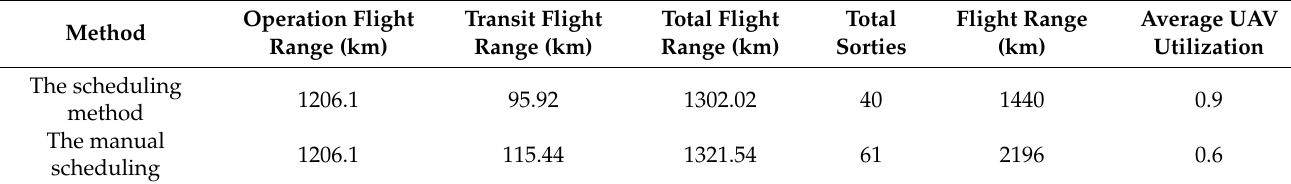
Table 5. Comparison of the UAV swarm scheduling method and manual